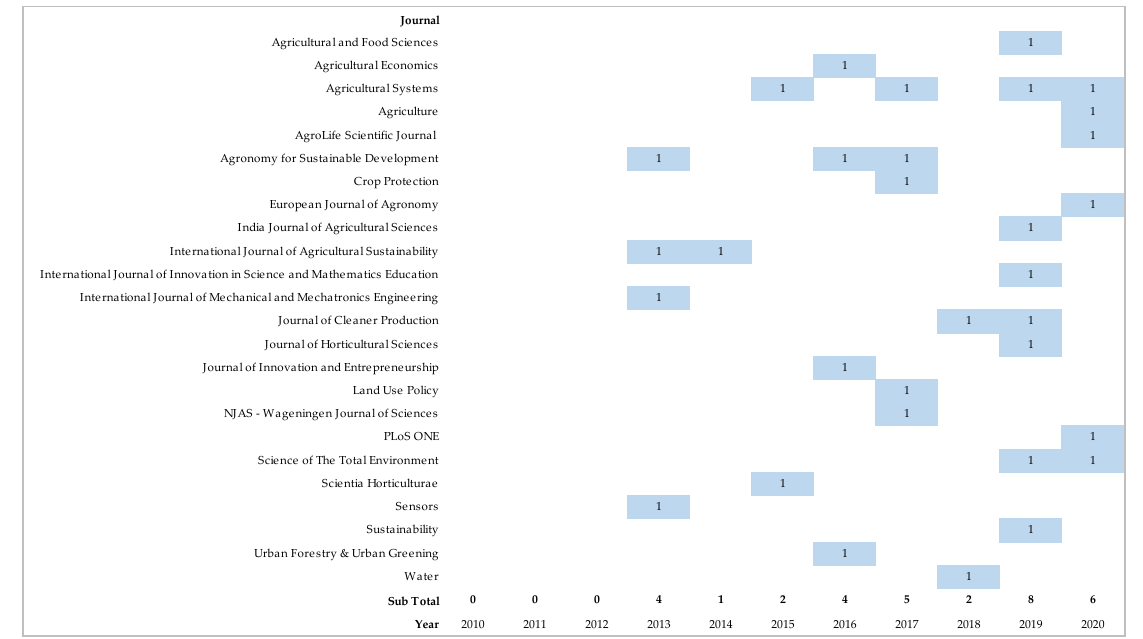
over the years (Figure 3).